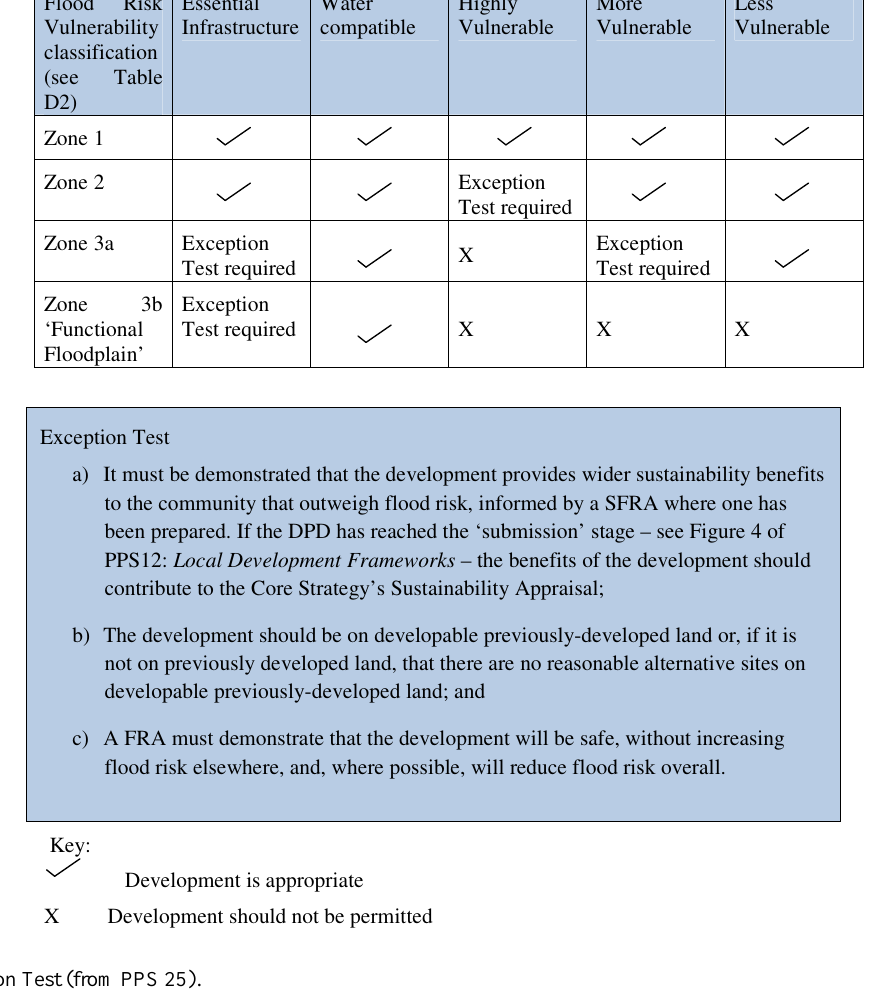
Figure 2. The Exception Test (from PPS 25)